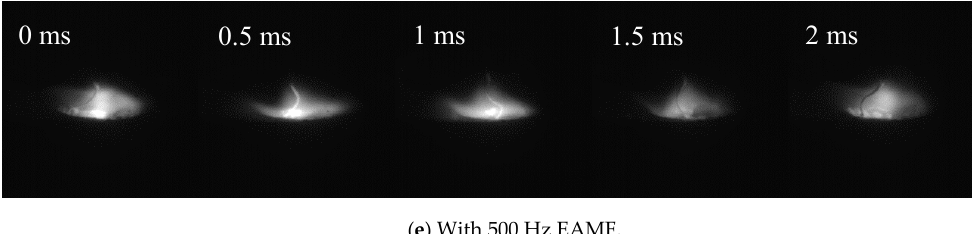
Figure 12. High-speed video observation of high-current GMAW metal transfer processes with EAMFs.